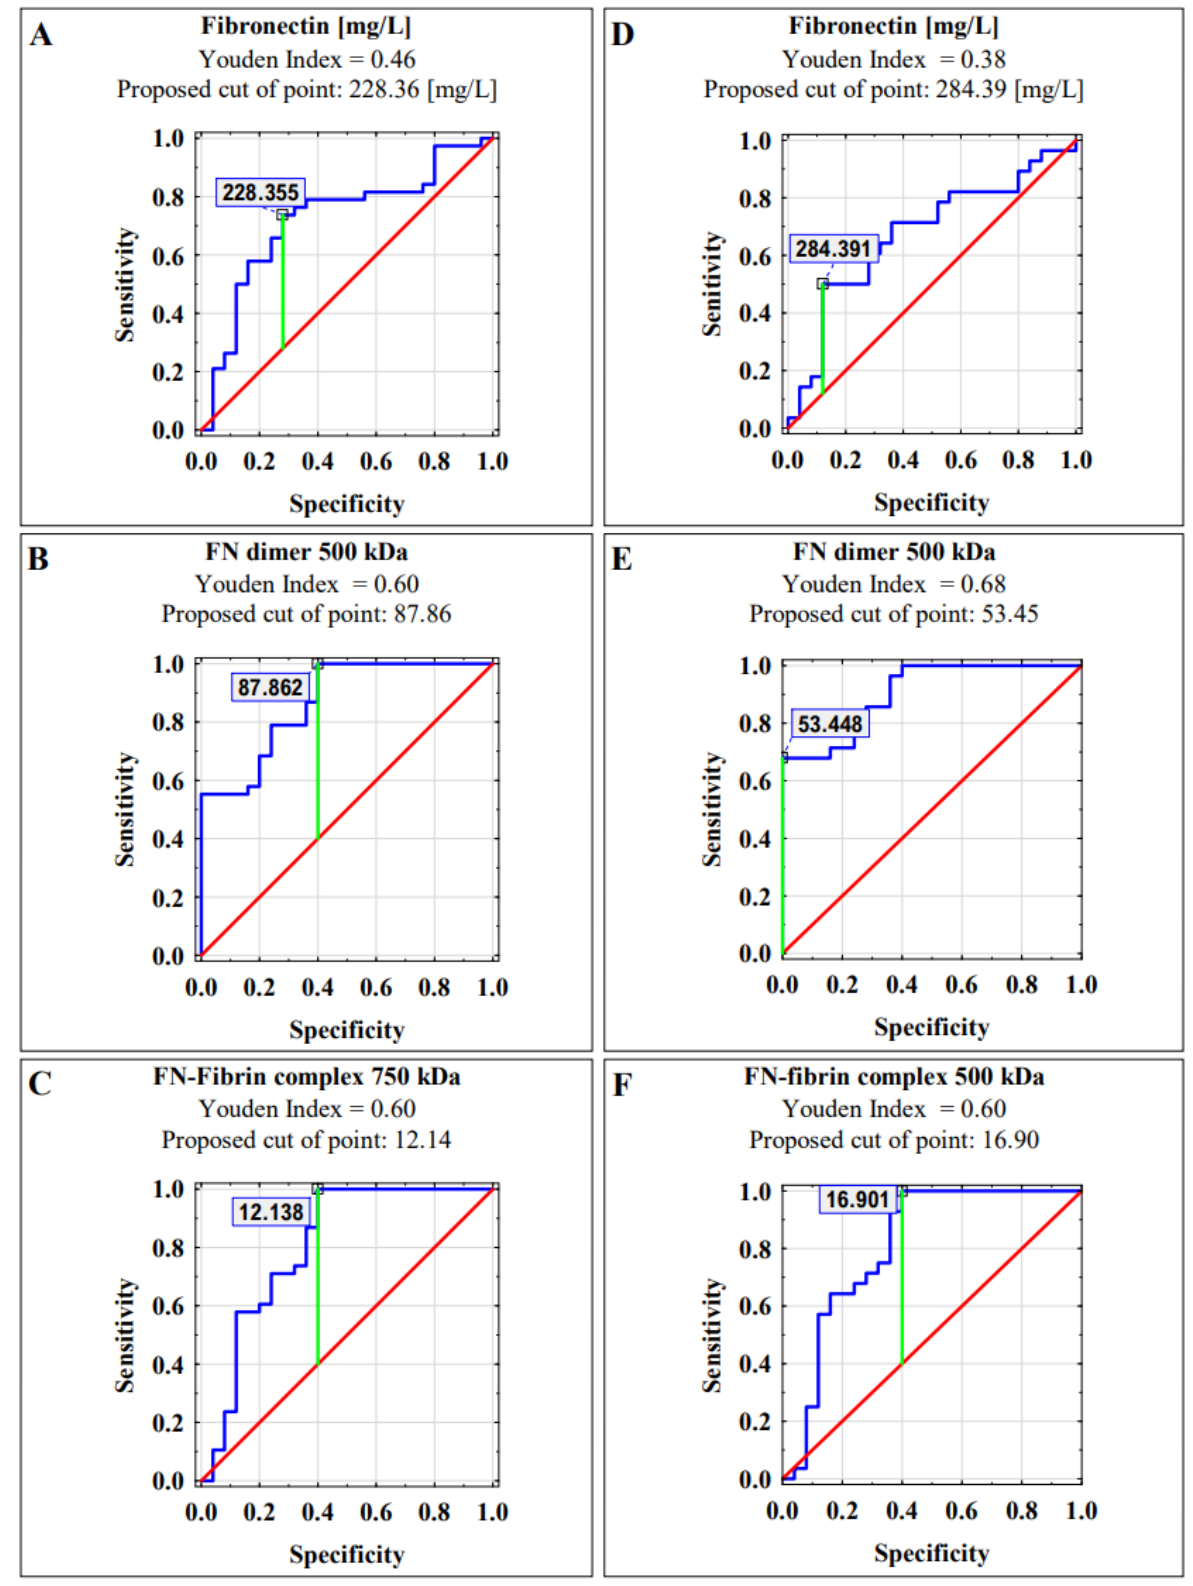
Figure 4. Receiver operating characteristic (ROC) curves for blood plasma FN concentration, FN dimer 500 kDa and FN-fibrin complex 750 kDa as markers of endometriosis ( A – C ) and fertility disorders ( D – F ). Data are given as area under the ROC curve (AUC) with a 95% confidence interval.